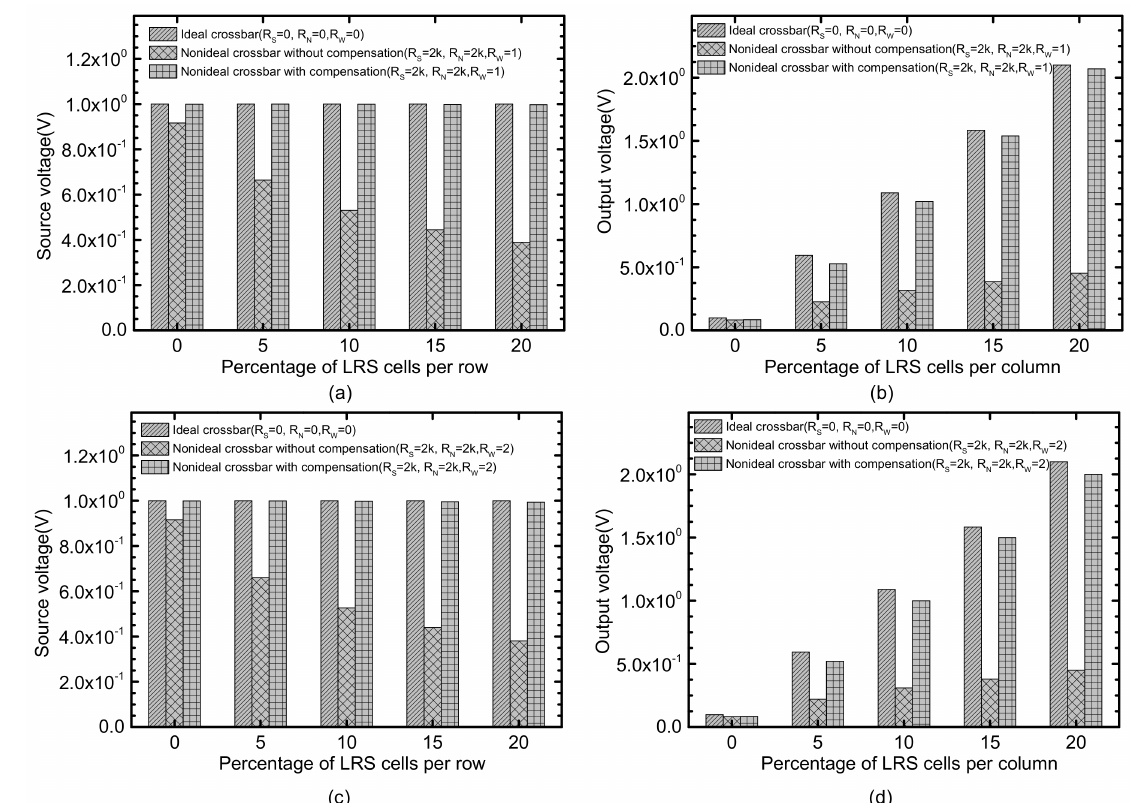
Figure 4. ( a ) Comparison of the source voltages of the nonideal crossbars between without and with the correction circuit for R S = 2 k Ω and R W = 1 Ω per cell. ( b ) Comparison of the output voltages of the nonideal crossbars between without and with the correction circuit for R N = 2 k Ω and R W = 1 Ω per cell. ( c ) Comparison of the source voltages of the nonideal crossbars between without and with the correction circuit for R S = 2 k Ω and R W = 2 Ω per cell. ( d ) Comparison of the output voltages of the nonideal crossbars between without and with the correction circuit for R N = 2 k Ω and R W = 2 Ω per